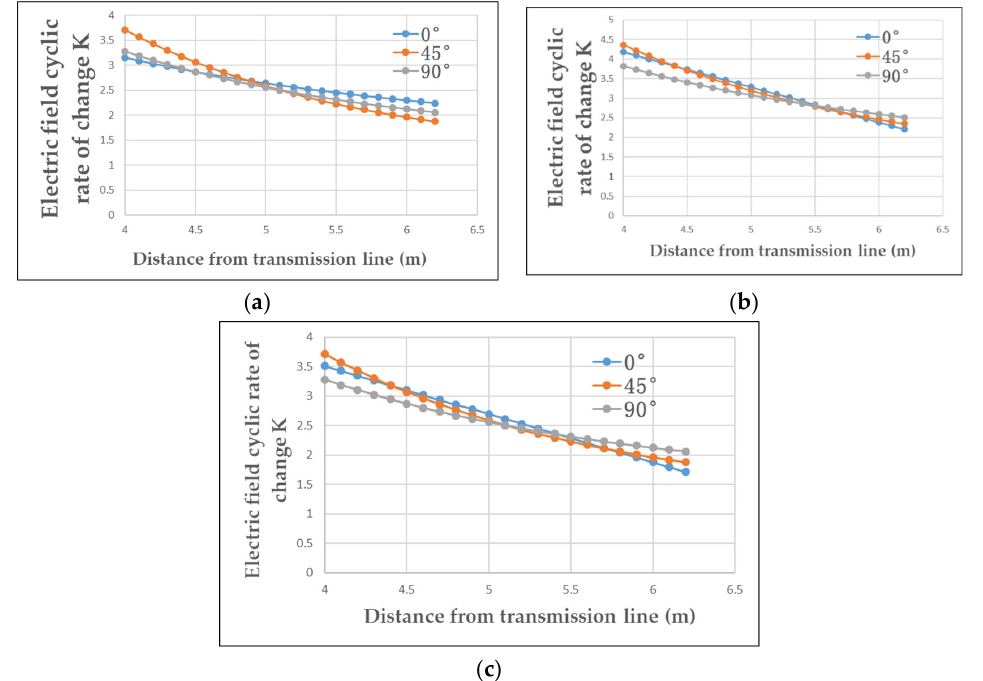
Figure 10. K value curve of 110 kV in different angles and different arrangement modes. ( a ) Hori- zontal arrangement K value curve; ( b ) triangle arrangement K value curve; ( c ) inverted triangle arrangement K value curve.